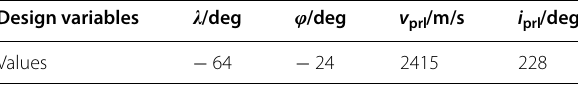
Table 4 The optimal values of the design variables with the high‑precision